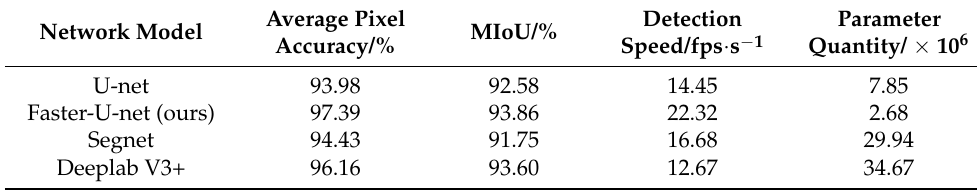
Table 2. Performance comparison of different network models.